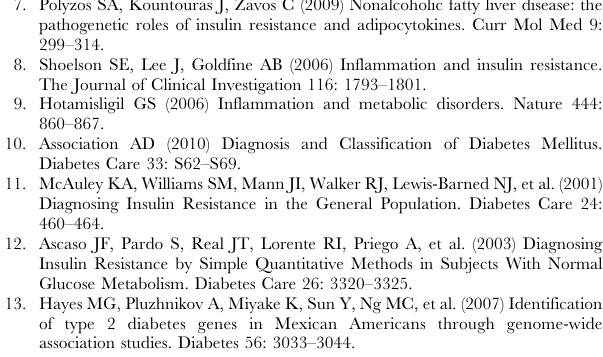
Table S1 Identification of HOMA-IR corrected factors by SVM and BLR. Table S2 Reference ranges of the HOMA-IR corrected factors. Table S3 The specificity and sensitivity for insulin resistance syndrome of fine-scans of the series of HOMA-IR cutoff